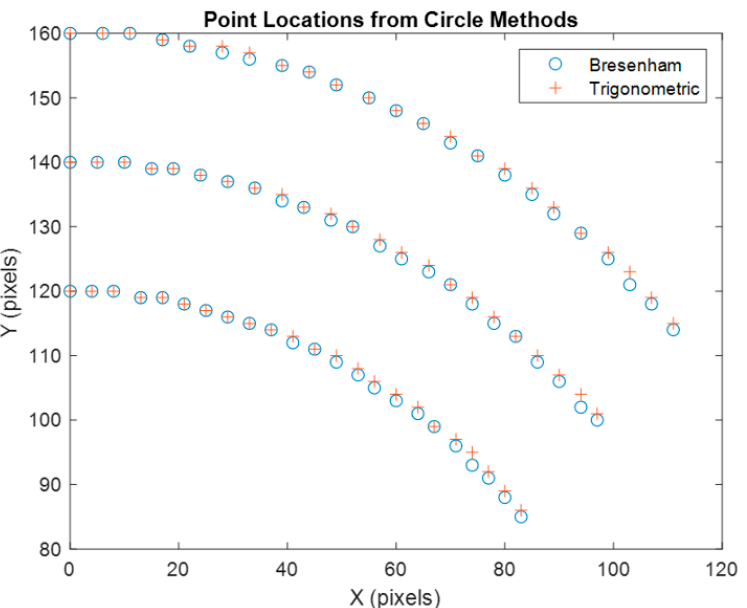
Figure 13. Circle points generated by the approximation method and the conventional trigonometric- based